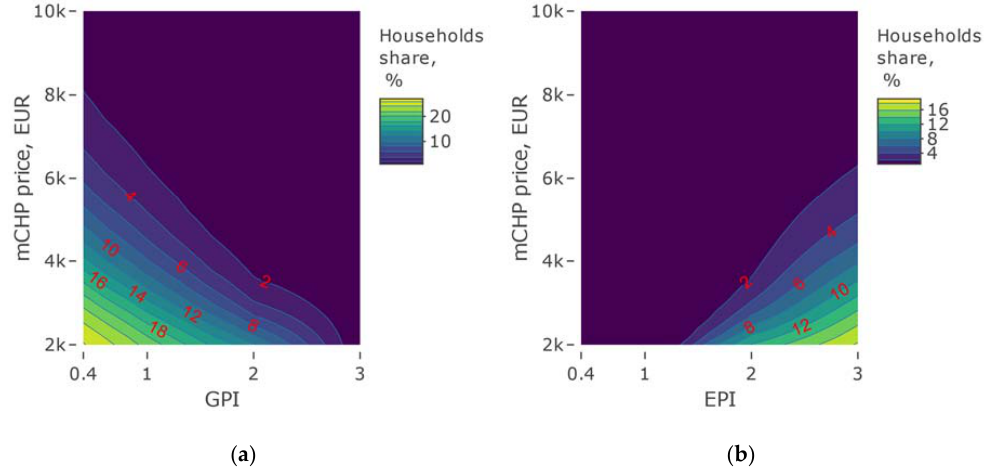
Figure 13 . Household share for: ( a ) EPI =2.0 and different GPI; ( b ) GPI = 2.0 and different EPI.